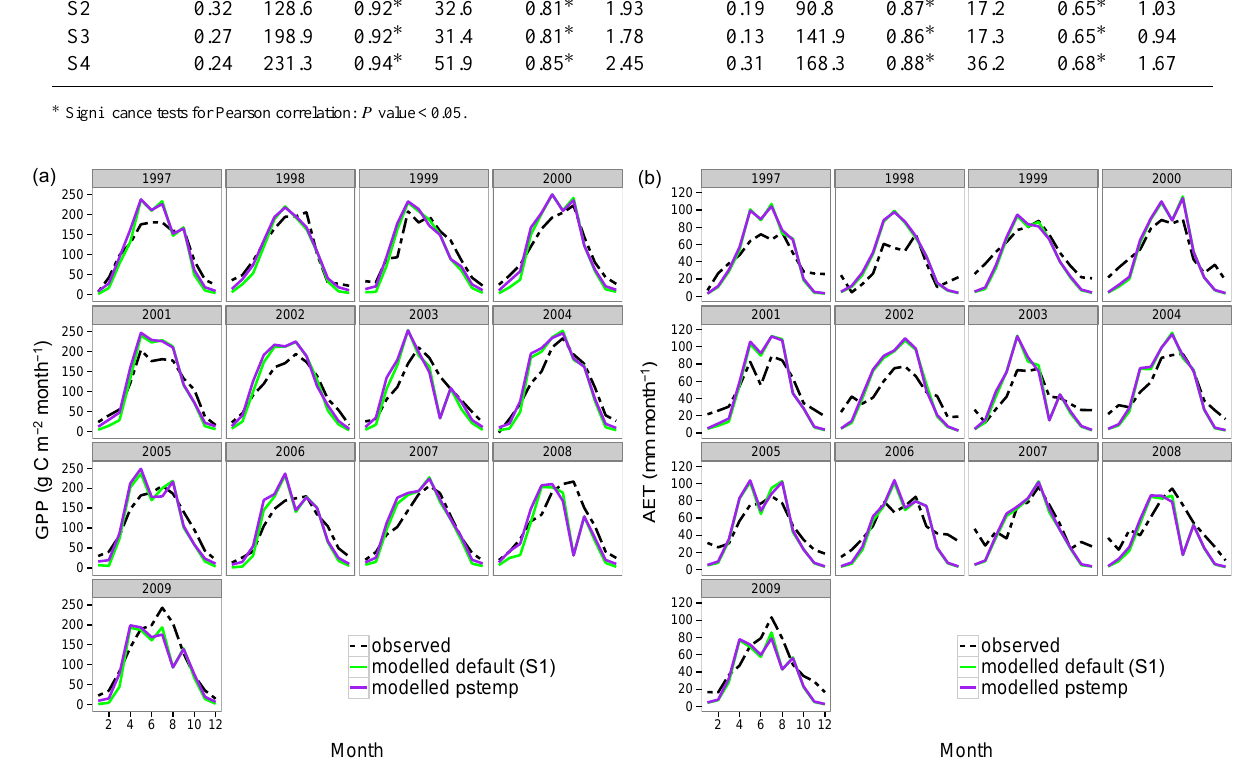
Figure 3. Observed (black dotted line) and modelled values for default (S1, green line) and changed temperature response (pstemp, purple line) runs. (a) Monthly values for GPP (gCm − 2 month − 1 ). (b) Monthly values for AET (mmmonth − 1